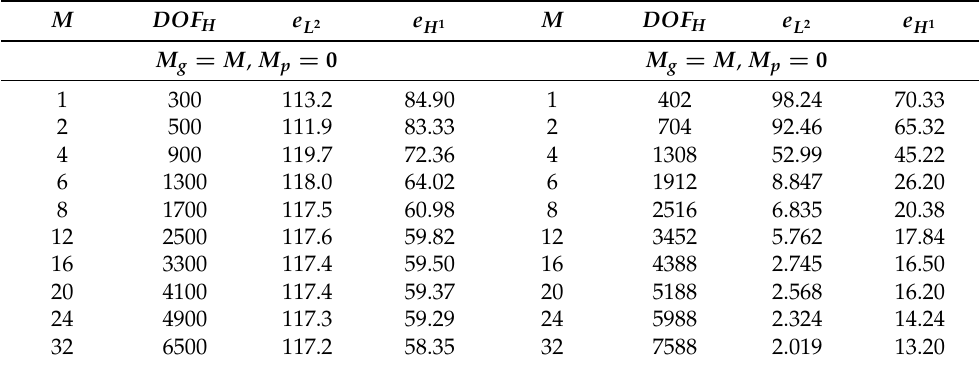
Table 4. Elasticity problem. Case 2 (non-homogeneous boundary conditions). Relative L 2 and H 1 error in %. DOF h =